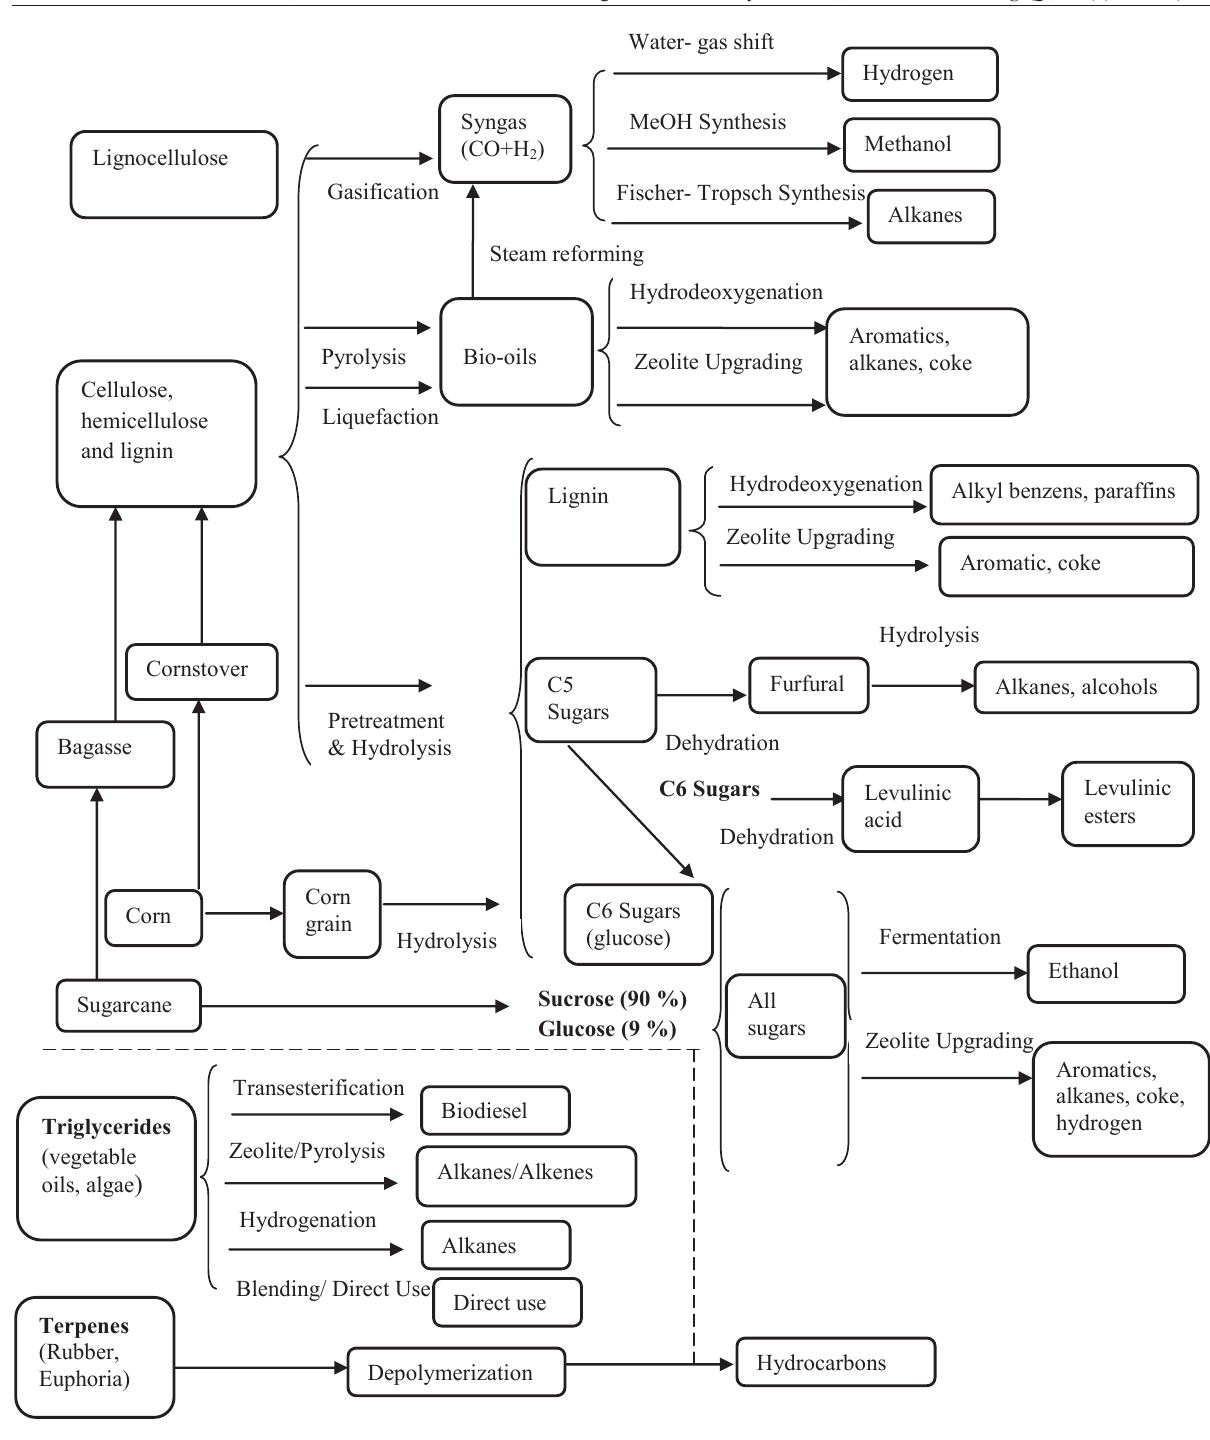
Fig. 2 Known routes for the production of liquid fuels from biomass